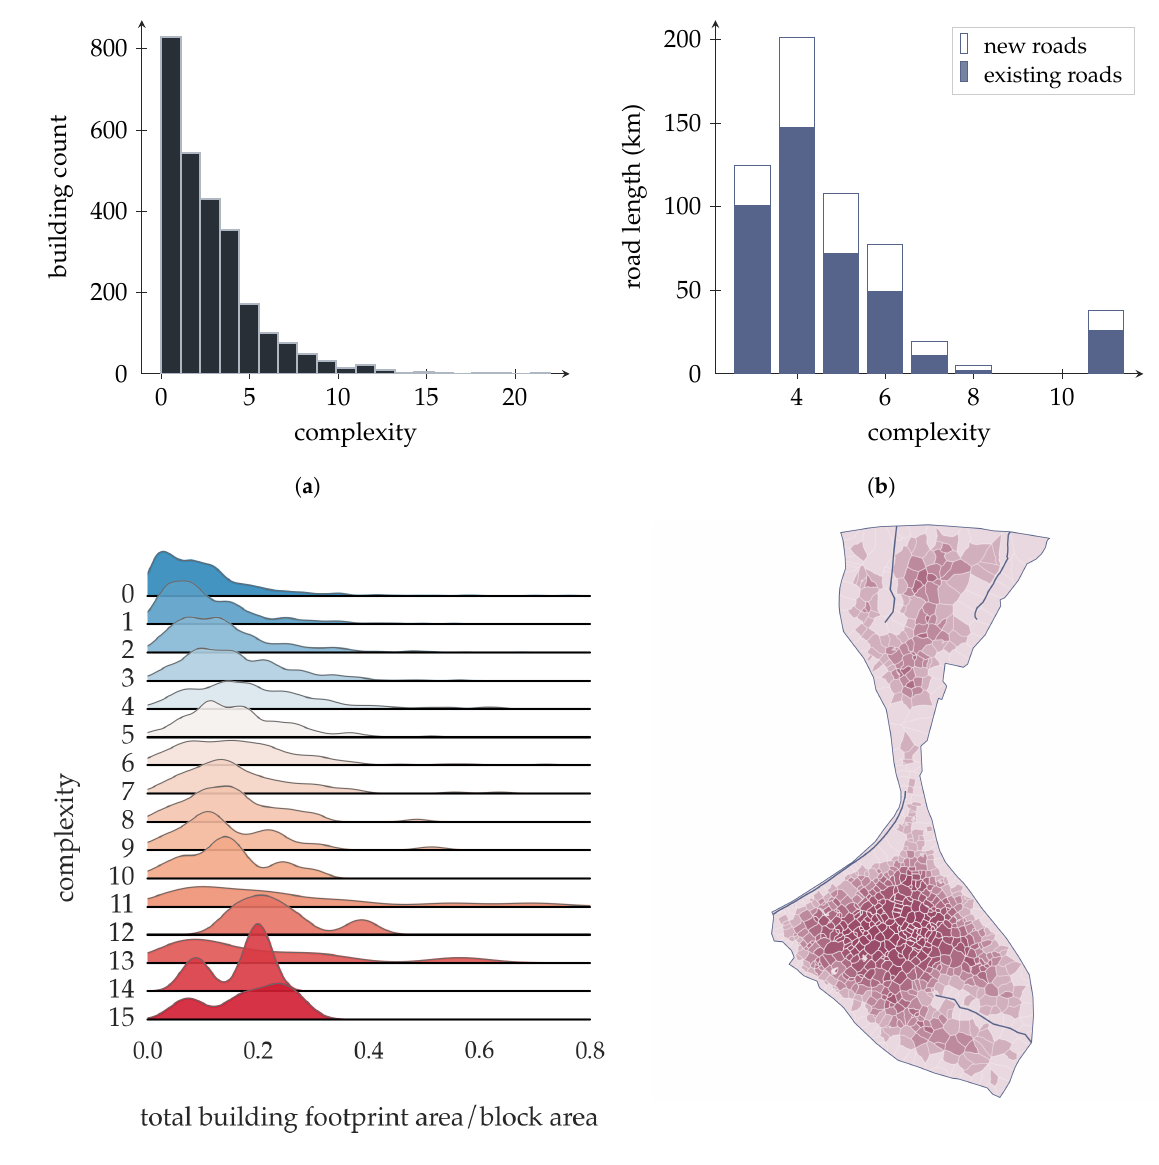
Figure 9. Analysis of Block Characteristics for Monrovia, Liberia. ( a ) Histogram of buildings by block complexity. ( b ) Distribution of proposed new road construction by block complexity. ( c ) Kernel density estimates for distributions of building-block areal ratios at each value of k observed (denoted “complexity” in the figure) ( d ) Example of a high- k block whose morphology suggests bisection before reblocking is attempted as an appropriate